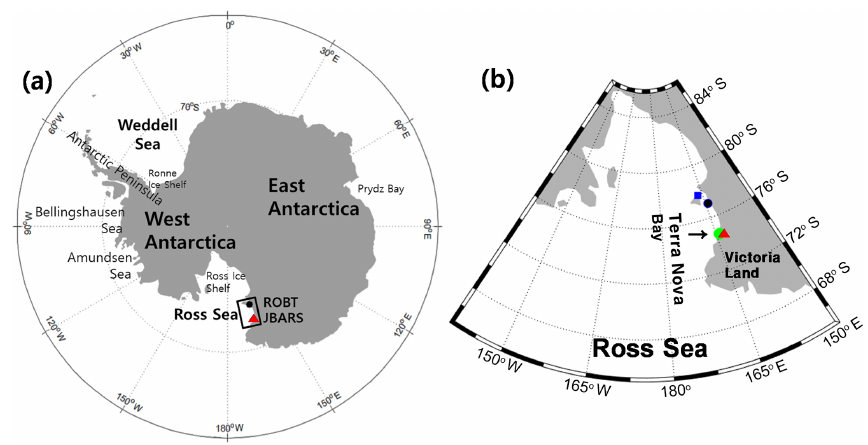
Figure 2. Maps showing (a) the locations of the two tidal observation stations employed in this study within a wider Antarctic context: Jang Bogo Antarctic Research Station (JBARS, ) and Cape Roberts (ROBT, ); (b) the case study station locations relative to two other (previous) temporary tidal observations stations, McMurdo Station ( ) and Mario Zucchelli Station ( ), in the Ross Sea. Table 1. Major tidal harmonic results for diurnal and semidiurnal constituents from harmonic analyses of sea level observations: the year-long (2013) record from ROBT, and 17.04d record (29 January to 15 February 2017) and 20.54d record (29 December 2018 to 18 January 2019) from JBARS in the Ross Sea (see source details in Sect. 2). For the JBARS tidal harmonic analyses, the inference method was used to infer the P 1 constituent from the K 1 , and the K 2 constituent from the S 2 , with their amplitude ratios and phase lag differences obtained from harmonic analysis of the long-term ROBT 2013 reference station record. Tidal constituents ROBT (2013) JBARS (2017) JBARS (2019) and characteristics